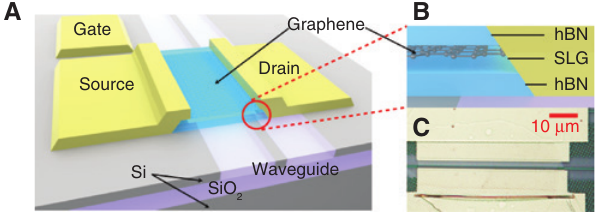
Figure 3: (A) Schematic of the graphene/boron nitride heterostruc- ture photodetector integrated with a silicon box waveguide [15]. (B) Cross-sectional view of the side-contacted BN/SLG/BN detector. (C) Optical image of the finished waveguide-graphene photodetector.